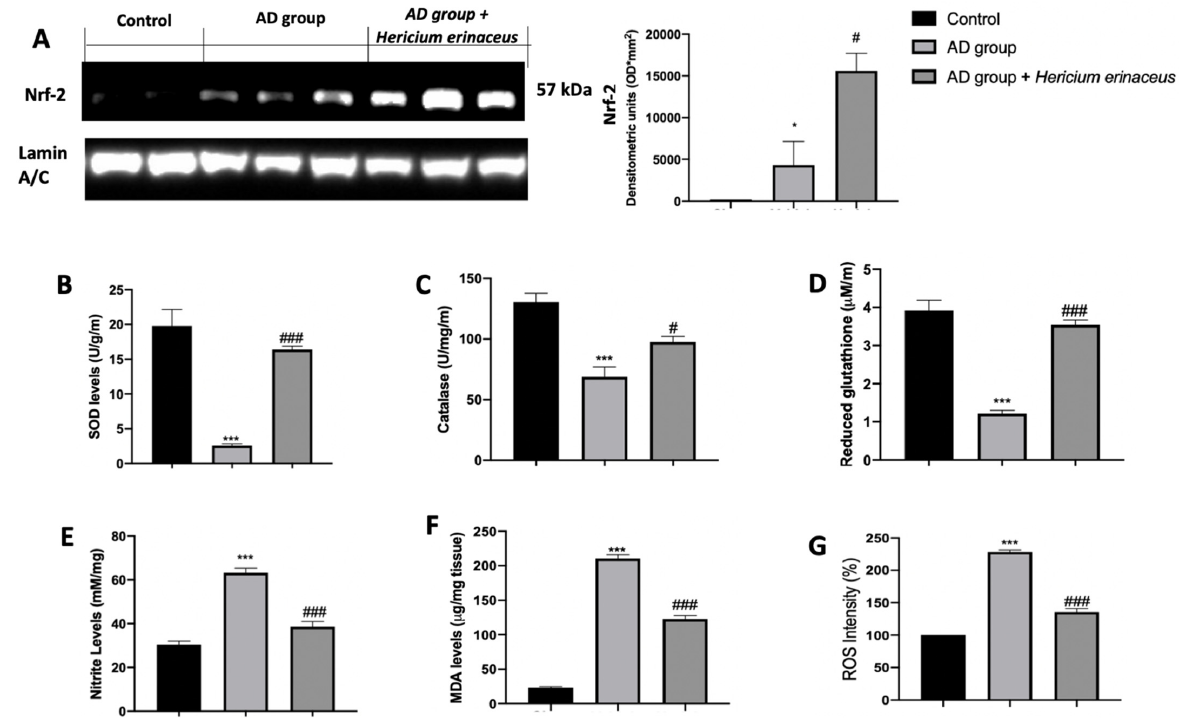
Figure 3. Hericium erinaceus administration decreased pro-oxidative modifications in hippocampus: Western blot analysis of Nrf2 expression ( A ), SOD levels ( B ), CAT activity ( C ), GSH levels ( D ), nitrite levels ( E ), MDA levels ( F ), ROS levels ( G ). For western blot and biochemical analyses, n = 5 animals from each group and for each analysis were employed. A p -value of less than 0.05 was considered significant. * p < 0.05 vs. control, # p < 0.05 vs. vehicle, *** p < 0.001 vs. control, ### p < 0.001 vs. vehicle.